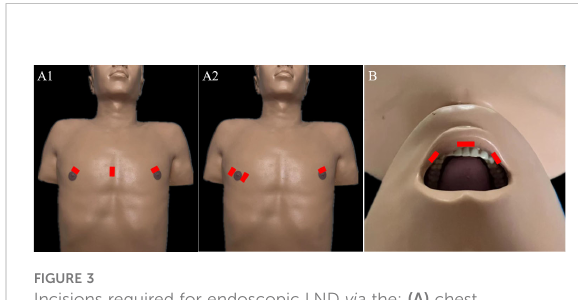
FIGURE 3 Incisions required for endoscopic LND via the: (A) chest approach and (B) transoral